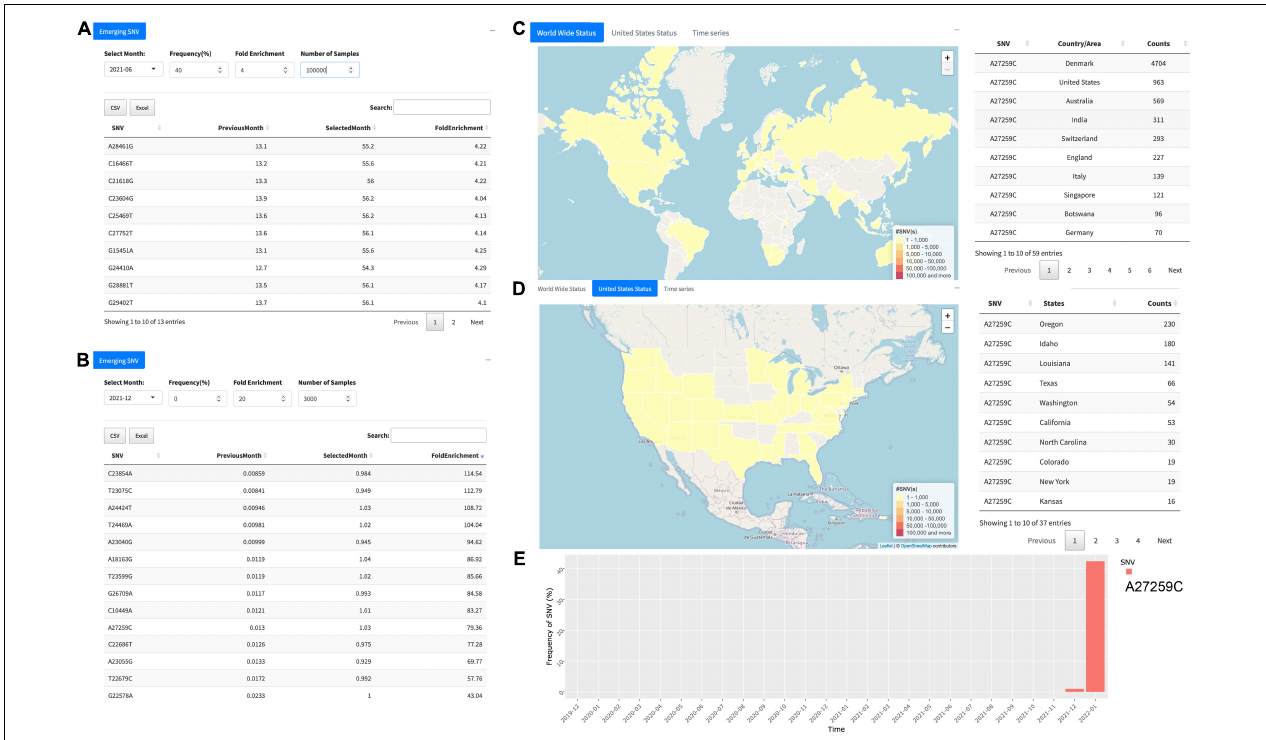
FIGURE 3 | Overview of the function “Emerging SNV.” (A) Emerging single-nucleotide variants (SNVs) identified in June 2021 with at least 40% SNV frequency, more than 4-F.E., and at least 1,00,000 samples. It turns out that all the SNVs passing the filter consist of B.1.617.2 (i.e., the delta variant). (B) Another example for December 2021 with cutoff of 20-F.E. and more than 3,000 samples harboring the SNV. All 14 SNVs identified, including A27259C, represent the omicron. (C) Distribution of A27259C around the world. (D) Distribution of the SNV in the United States. (E) The temporal pattern of A27259C prevalence, revealing its breakout in December 2021 and significantly a huge increase in January